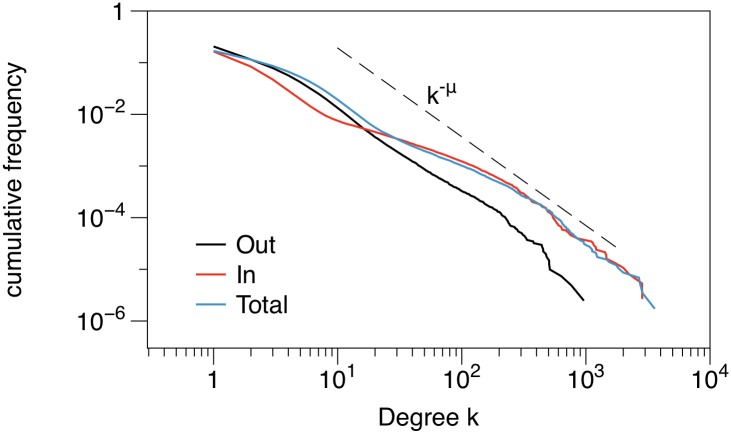
Degree distribution of the livestock trade network.The out-degree distribution can be approximated by a power law of the form pk ∼ k−μ with μ ≈ 2.7 (estimated using a maximum likelihood approach [49]). The figure shows the cumulative distribution to minimize fluctuations.